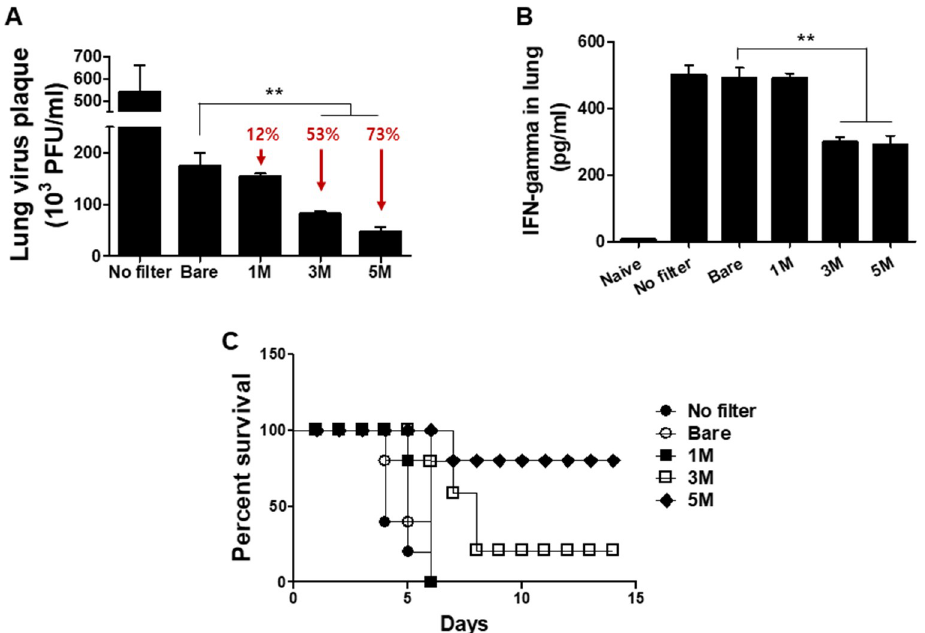
Fig 4. Virus infectivity study in mice using viruses passing through the filters. Mask filters coated with 1, 3, and 5 M of salt and aerosolized influenza viruses (A/H3N2, 8mg/ml, 3.5x10 6 pfu) were passed through filters. Passed viruses were harvested to infect mice, and virus titers and inflammatory cytokine in the lung, mouse survivals were assessed. (A) Lung virus titers (n = 6, mean ± SEM, �� P < 0.01), (B) lung inflammatory cytokine (IFN-gamma)) assay (n = 5, mean ± SEM, �� P < 0.01), and (C) survival